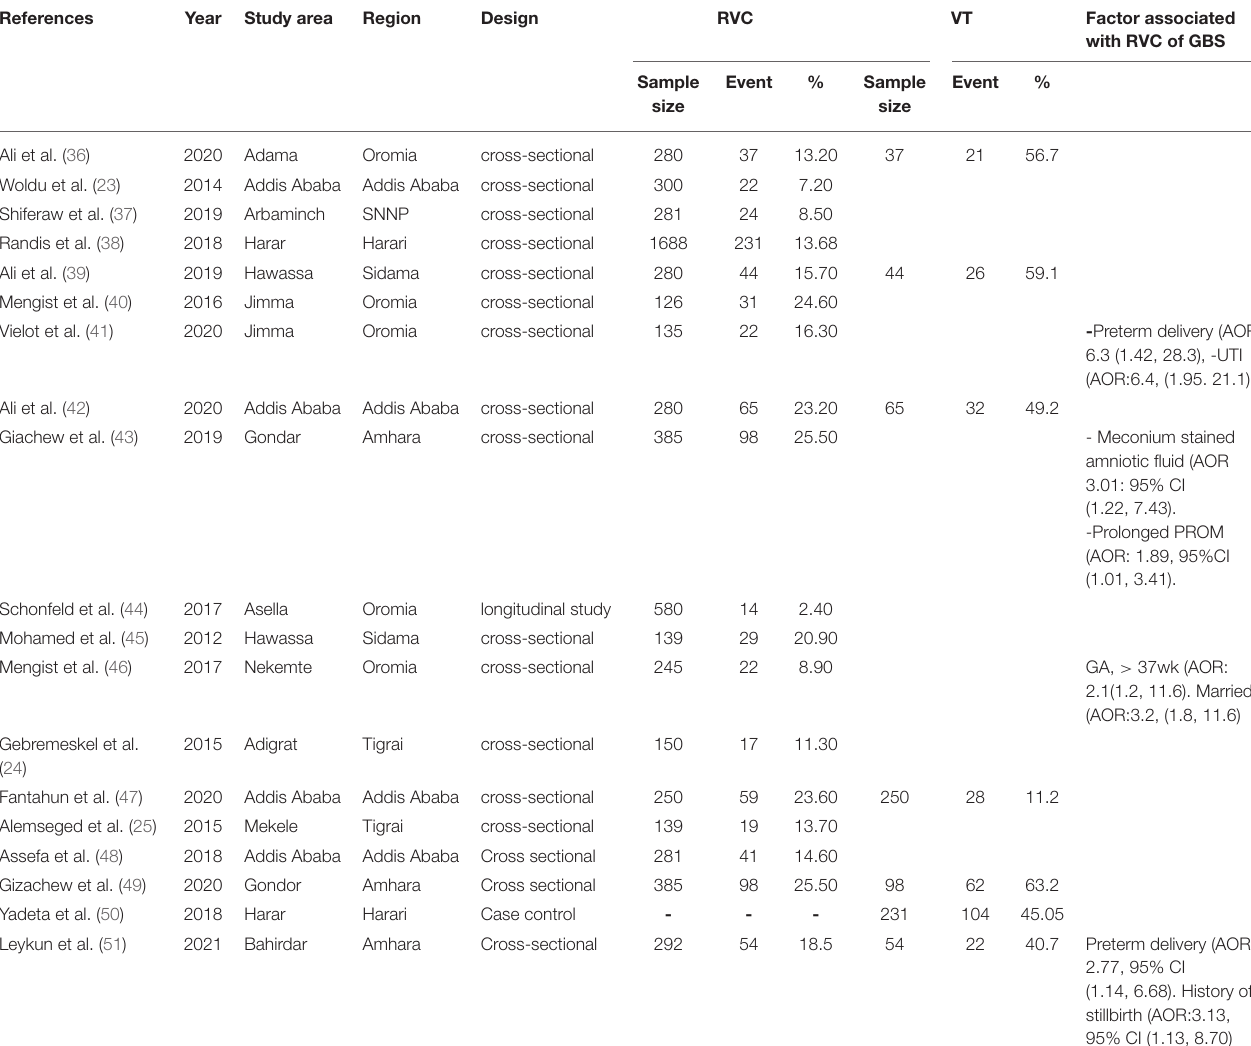
TABLE 1 | Characteristics of studies revealing recto-vaginal colonization of Group B streptococcus Ethiopia,